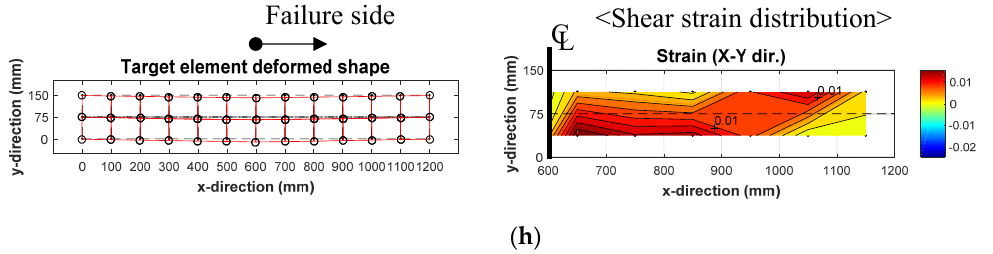
Figure 7. Shear strain distributions at failure loads. ( a ) TS-0 specimen; ( b ) TS-3 specimen; ( c ) TS-8 specimen; ( d ) TS-15 specimen; ( e ) TH-0 specimen; ( f ) TH-3 specimen; ( g ) TH-8 specimen; ( h ) TH-15